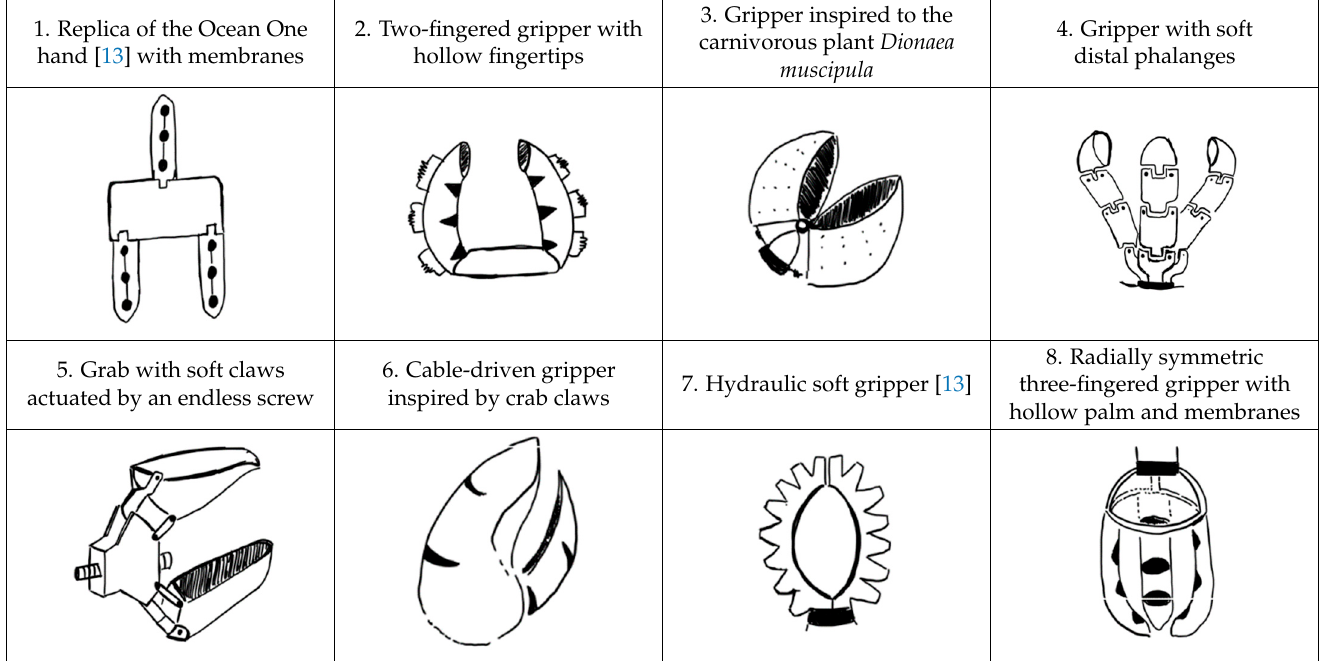
Table 2. Eight conceptual designs proposed to meet the requirement expressed by the end-users.